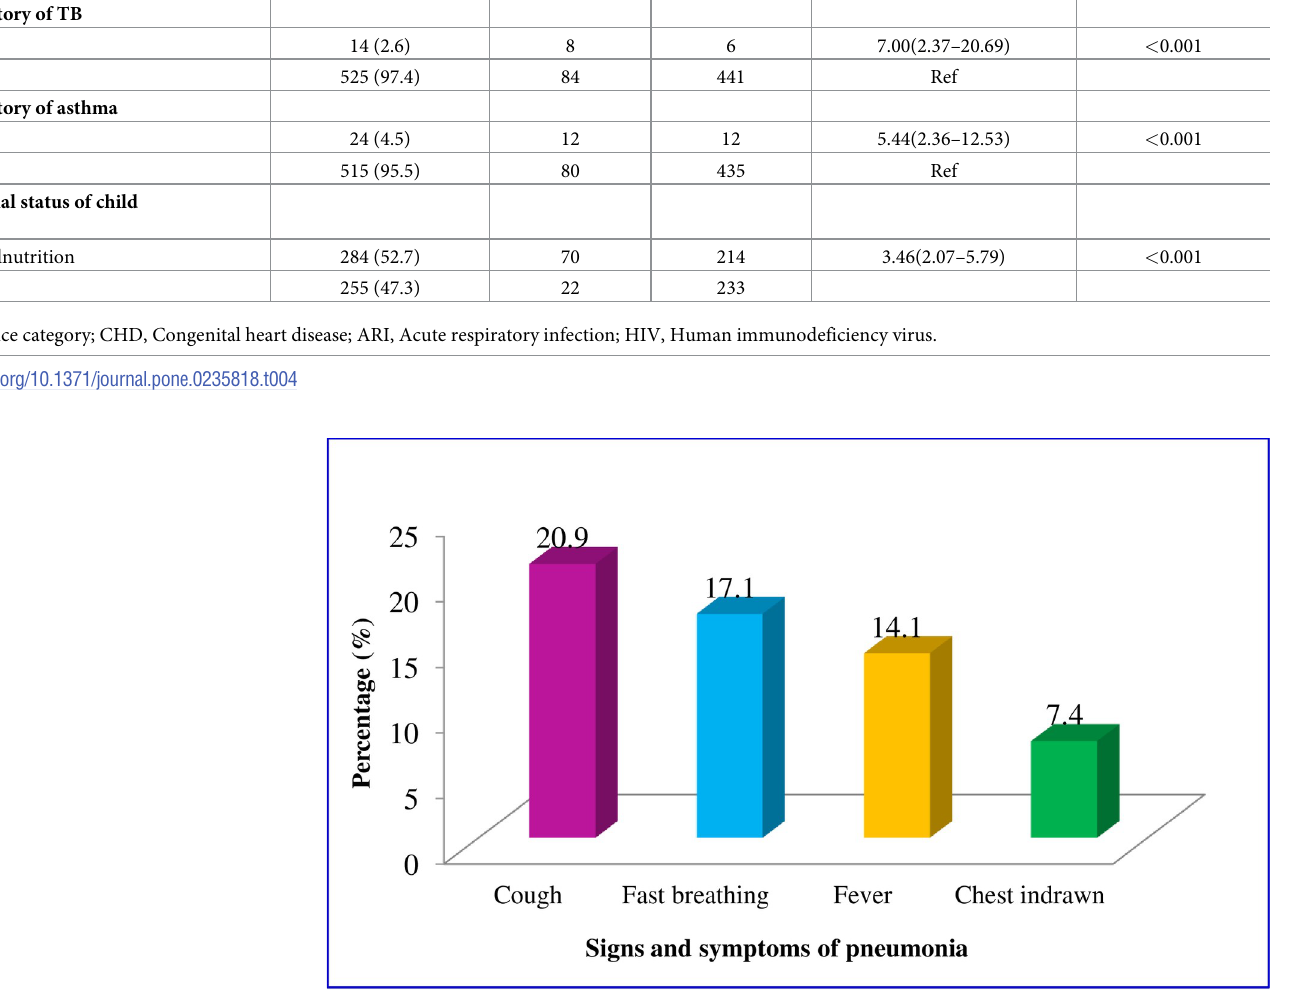
Fig 1. Signs and symptoms of childhood pneumonia in peri-urban areas of Dessie City, north-eastern Ethiopia, January—March 2019.